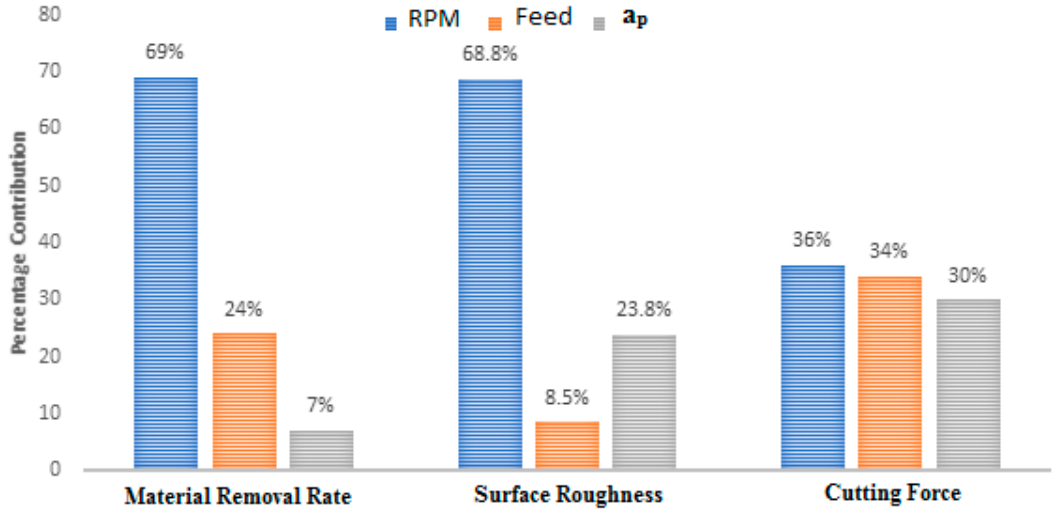
Figure 7. Percentage contributions of turning parameters on process response